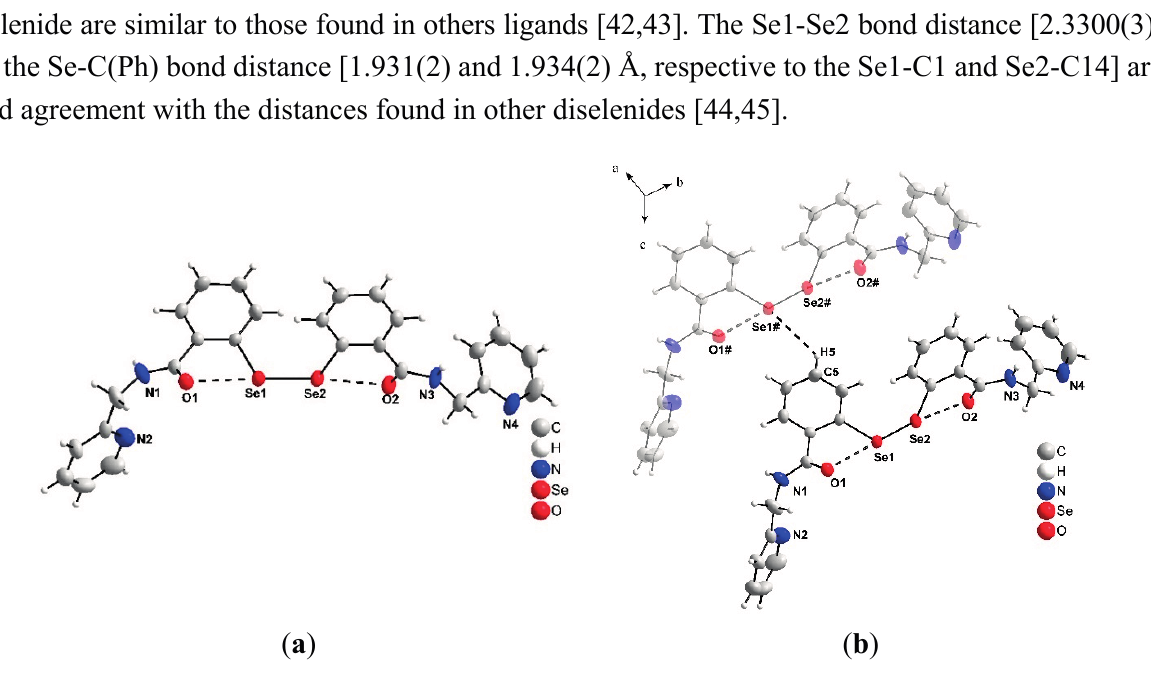
Figure 2. ( a ) Molecular structure of 5d with 40% thermal ellipsoids (using DIAMOND software); ( b ) Molecular and hydrogen interaction assembly of 5d . Symmetry operations used to generate equivalent atoms: (#) x , y , − 1 + z